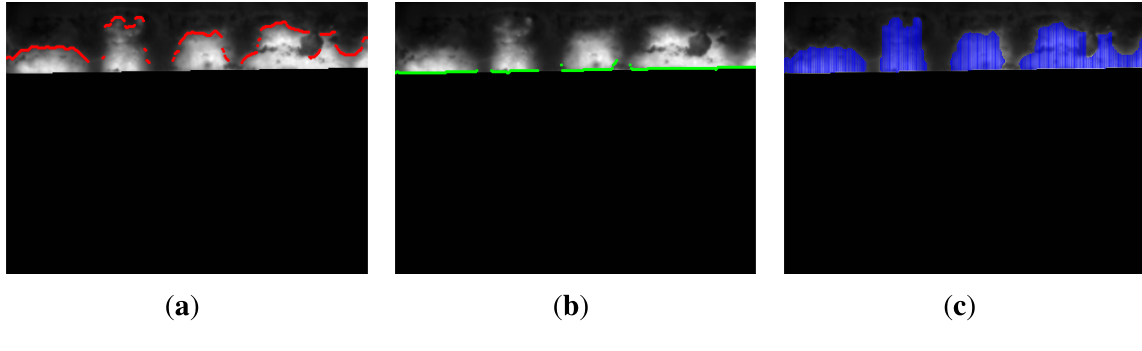
Figure 12. Heights in the flame front. ( a ) Top position. ( b ) bottom position. ( c )